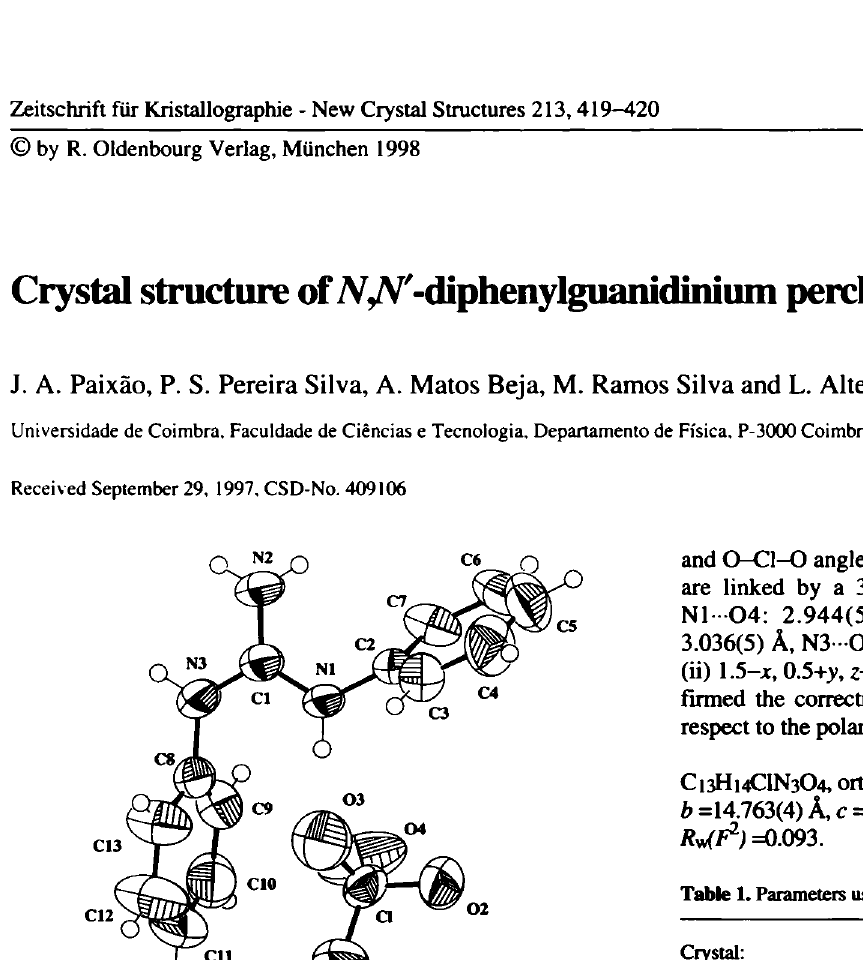
Table 1. Parameters used for the X-ray data collection Crystal: